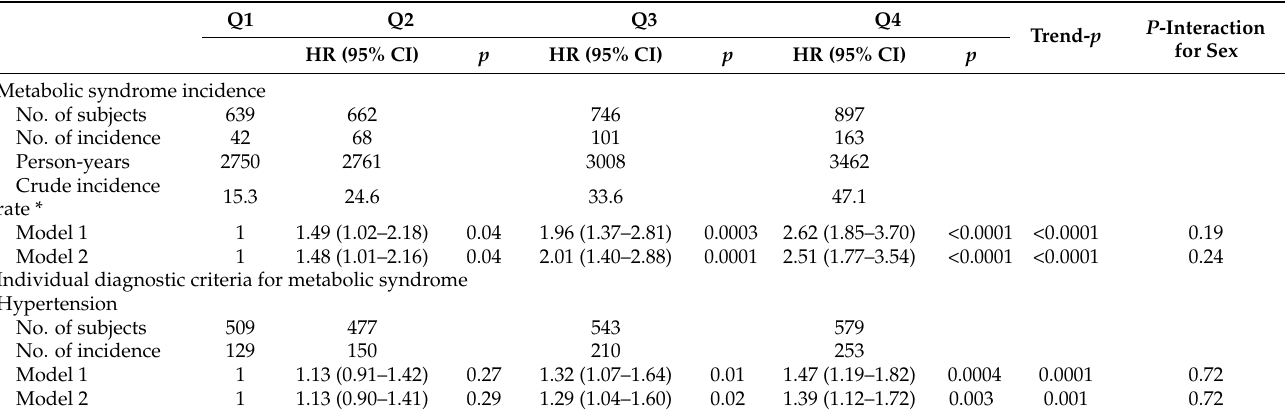
Table 5. Hazard ratios and 95% confidence intervals for the incidence of metabolic syndrome and its components according to the quartiles of the Unhealthy Dietary Pattern score for the Aichi Workers’ Cohort,